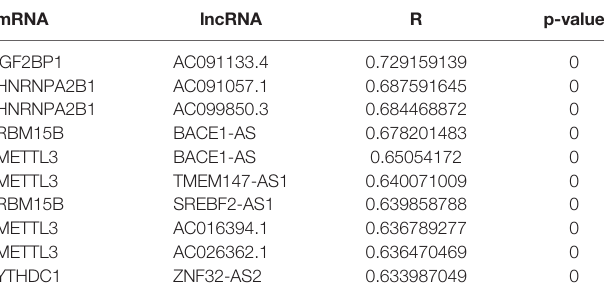
TABLE 3 | m6A related lncRNAs (Top